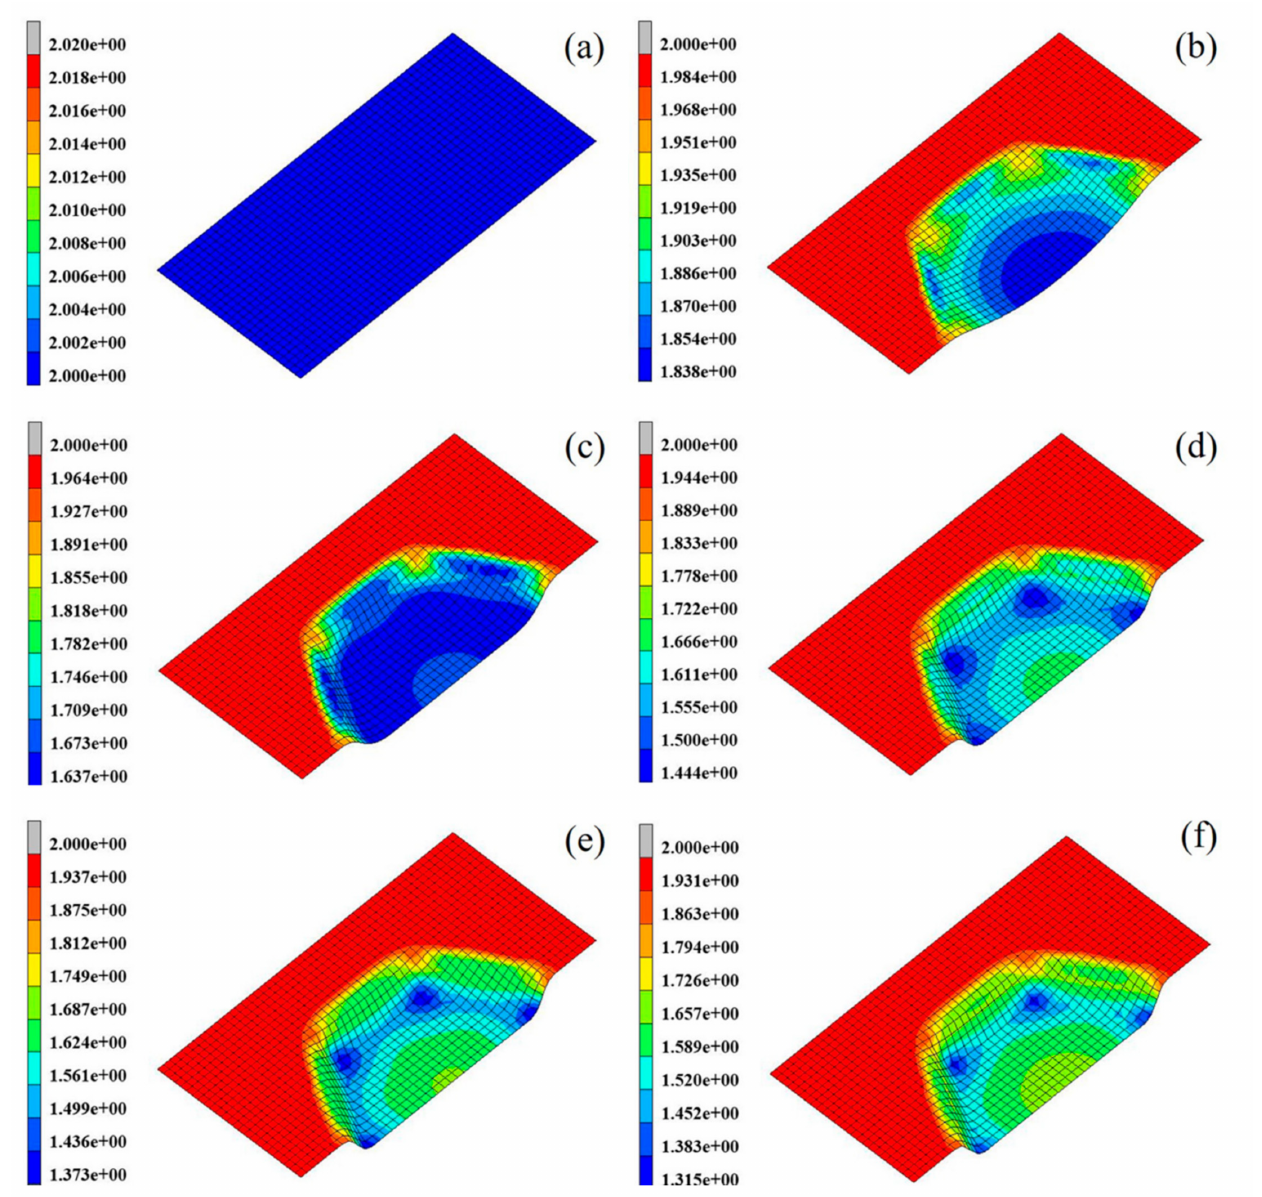
Figure 13. Thickness distribution of Mg-Re alloy at different stages of superplastic forming ( a ) 0s; ( b ) 50s; ( c ) 120s; ( d ) 250s; ( e ) 400s; ( f )